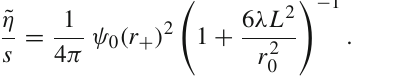
Right panel : AdS-RN BHs. ˜ η/ s are plotted for three selected values of the BH charge: above, at and below the critical value Q c = 1 / 6 at which the system undergoes the second-order phase transition. The dots (square) mark the maximum (minimum) of the temperature as a √ 2 /π . function of the BH